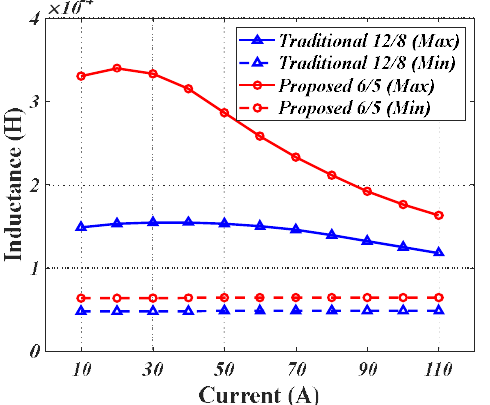
Figure 7. Inductance comparison between the two motors.